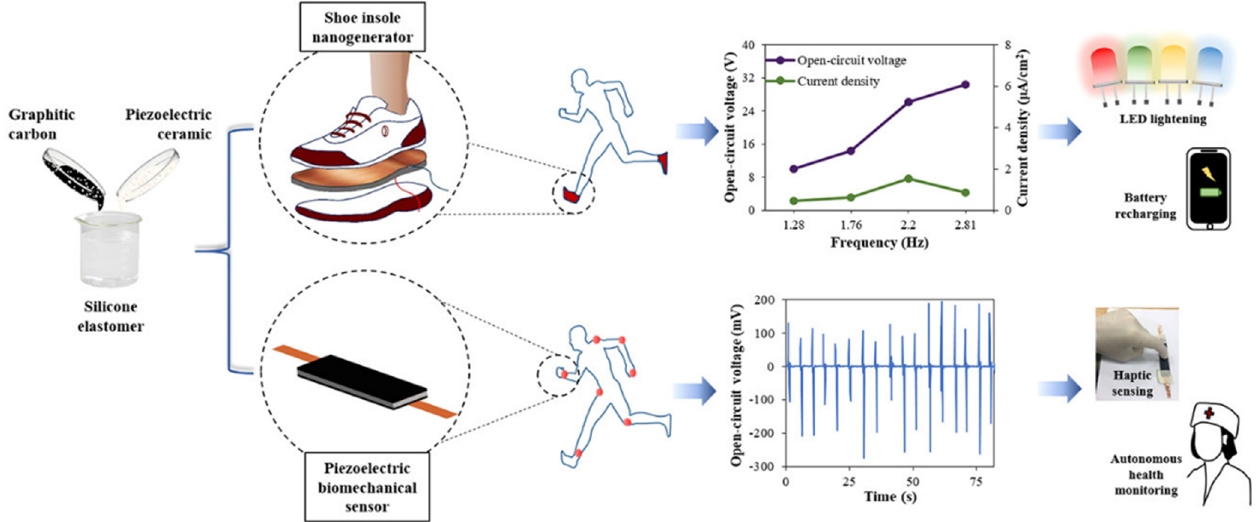
Figure 9. The proposed shoe-insole nanogenerator that can generate an open circuit voltage of ~27 V. The sensors used for movement detection responded to almost every joint movement [136]. Reprinted with permission from Ref. [136]. Copyright 2020 American Chemical Society.